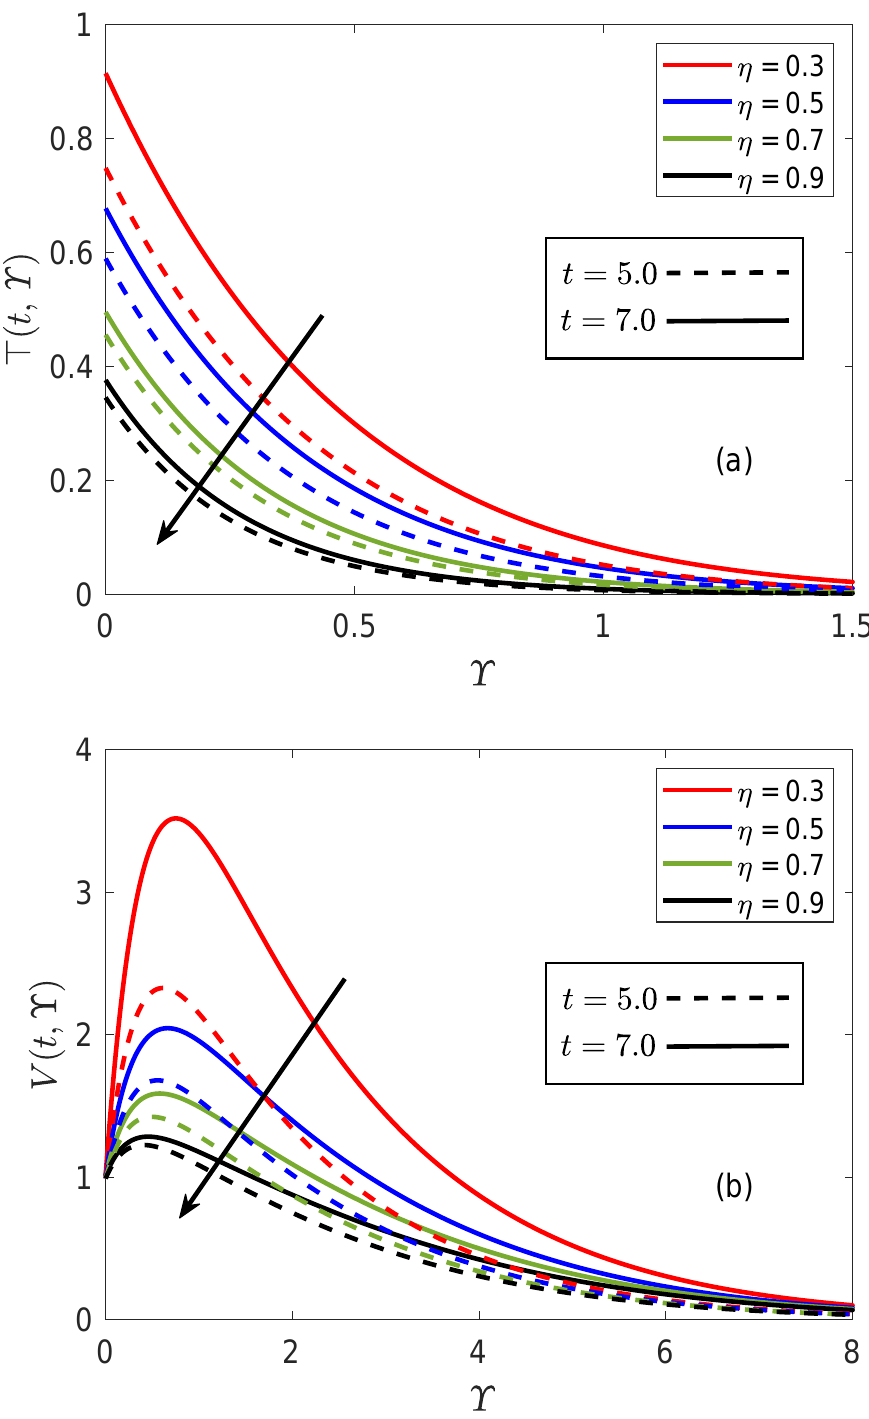
Figure 6. ( a ) Thermal patterns corresponding to change in η for larger time inputs. ( b ) Flow patterns corresponding to change in η for larger time